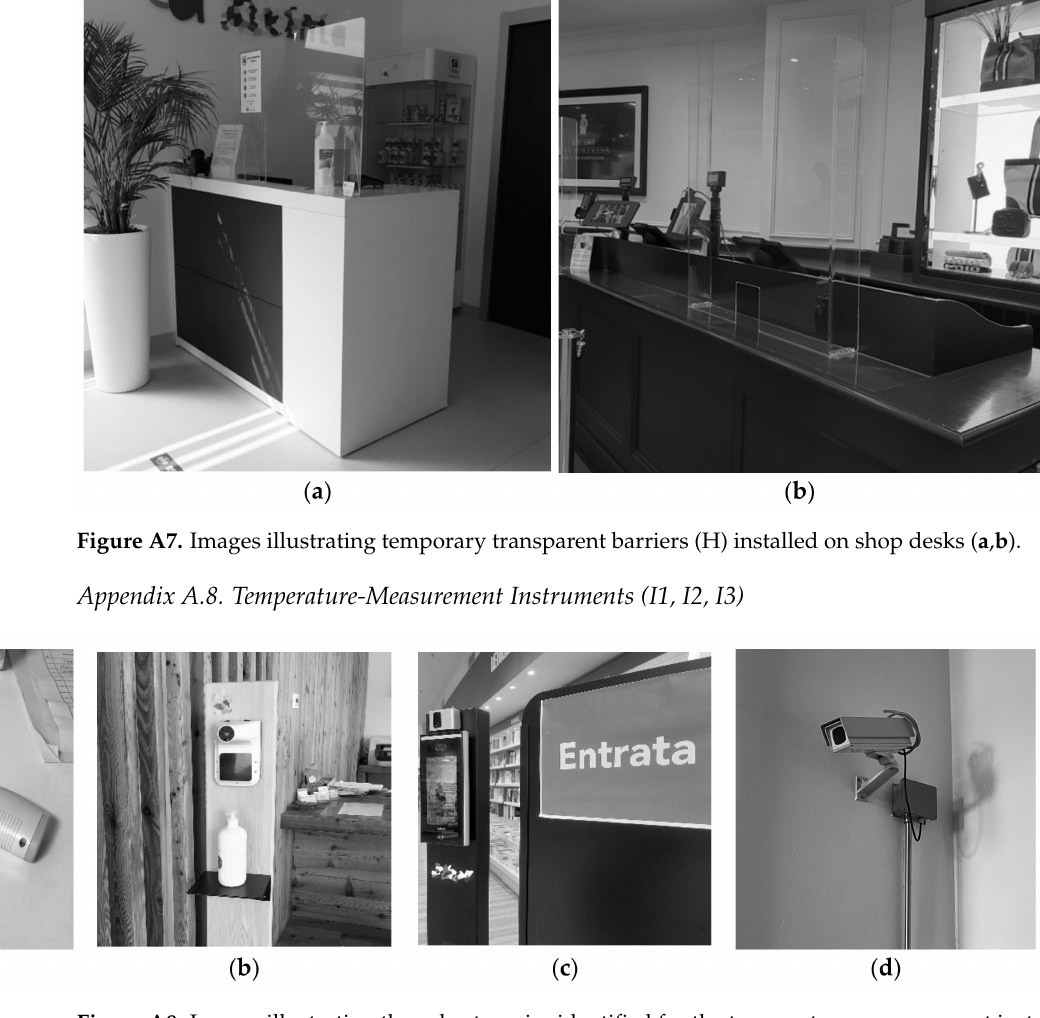
Figure A8. Images illustrating the subcategories identified for the temperature-measurement instru- ments: portable mono-user IR thermoscanner ( a ) (I1), fixed mono-user IR ( b ) or tablet ( c ) thermoscan- ners (I2), and dynamic multi-user thermoscanners ( d )